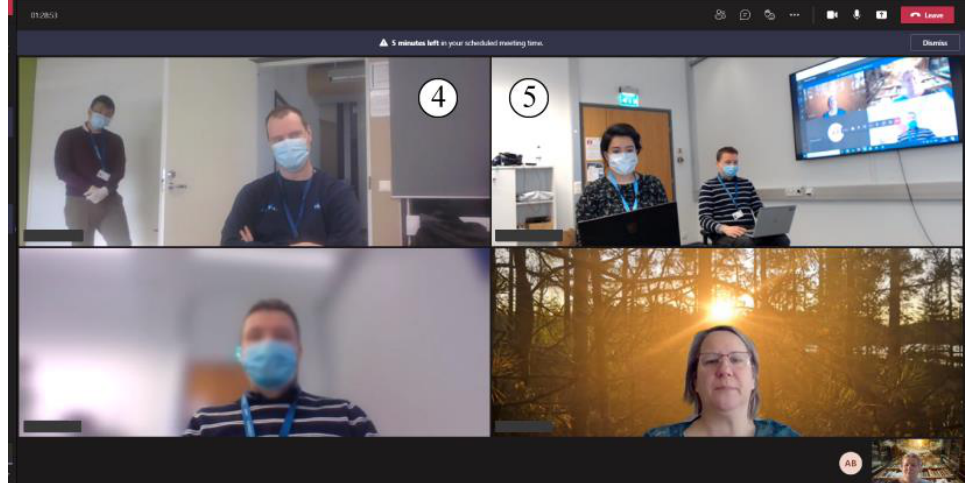
Figure 6. Group interview via Teams: ( 4 ) VR-participant 2 and support facilitator, ( 5 ) VR-participant 1 and main